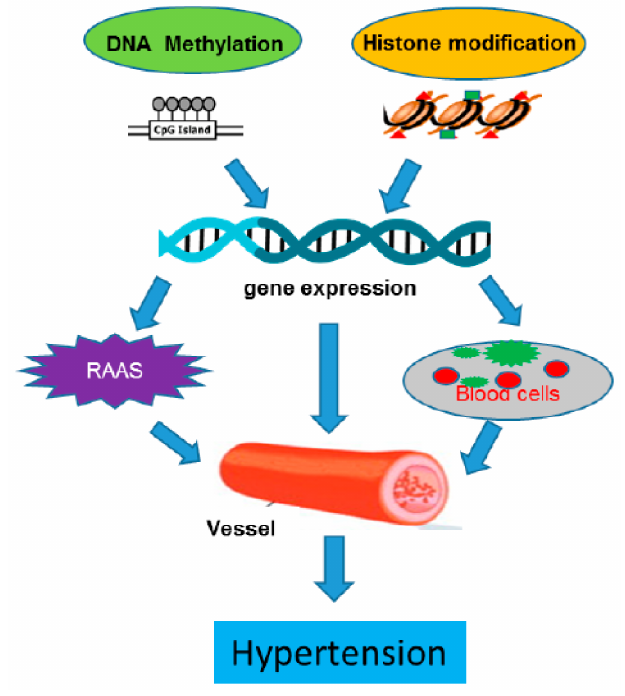
Figure 1. The illustration of the regulation DNA methylation and histone modification in